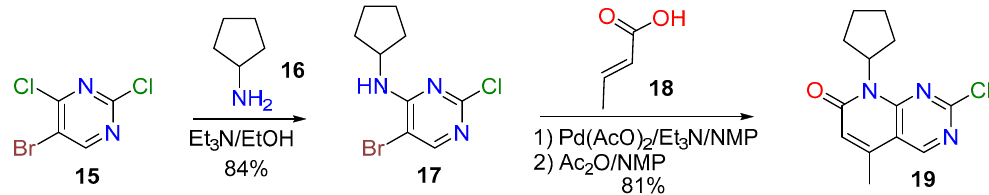
Figure 10. Synthesis of the palbociclib intermediate 19 from 5-bromo-2,4-dichloropyrimidine ( 15 ) .